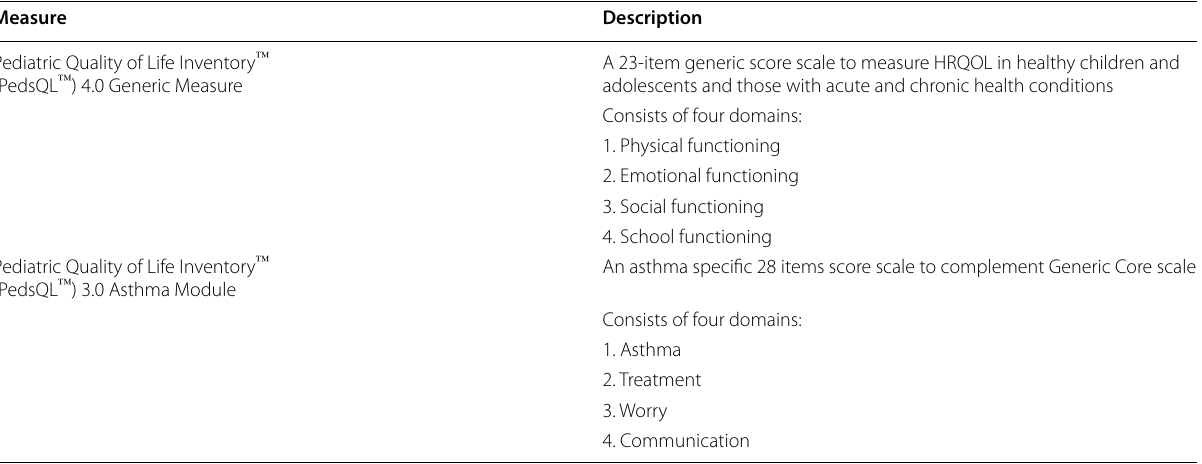
Table 1 Description of PedsQL ™ questionnaires Measure